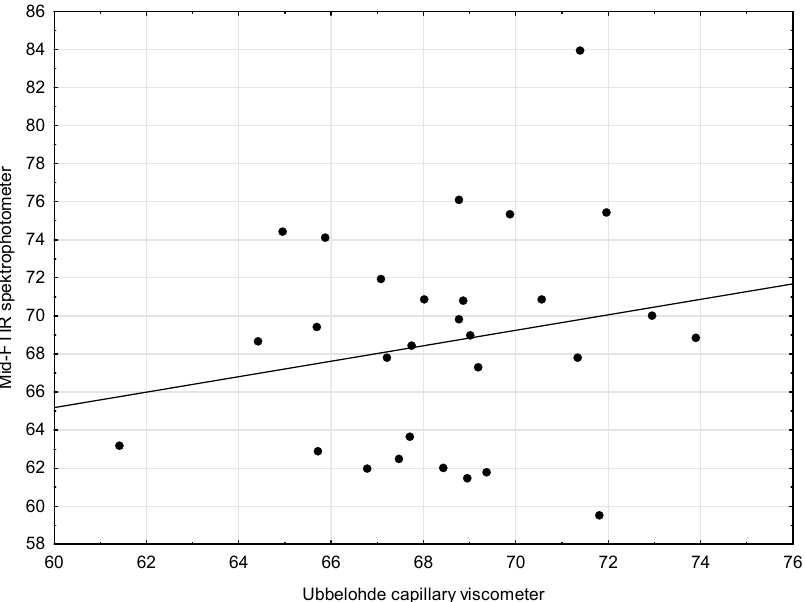
Figure 4. Scatter plots with regression lines for kinematic viscosity—Capillary viscometer and Mid-FTIR spectrophotometer—after removing the outlying samples: #3, #4, #5, #8, #12, #13, #18, #20, #21, #24, #34, #36, and #40.